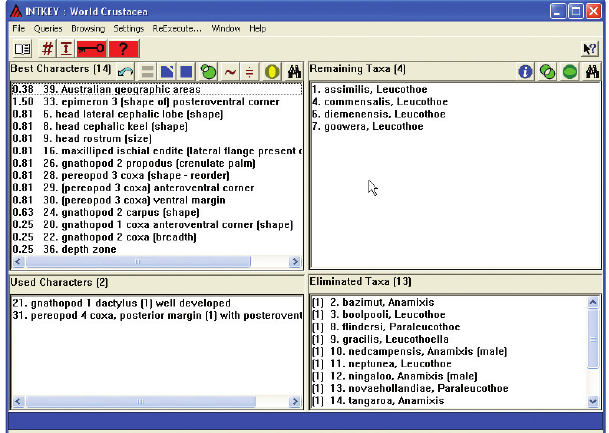
Figure 67. Character 31 separated the 8 Remaining Taxa into halves by eliminating 4